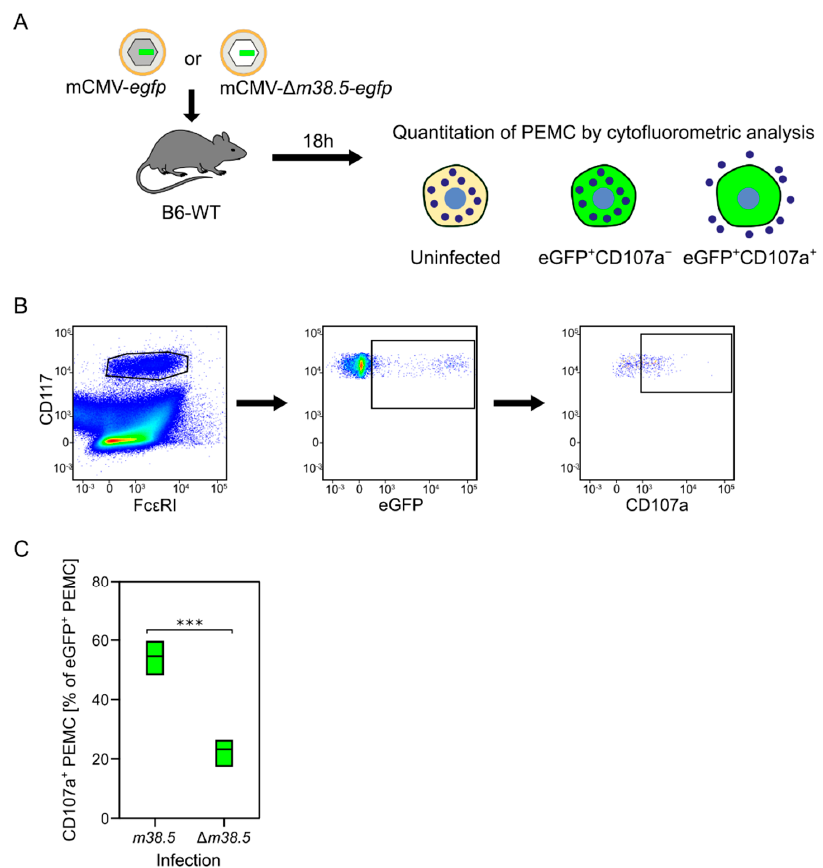
Figure 4. MC degranulation triggered by the anti-apoptotic mCMV protein vMIA-m38.5. ( A ) Sketch of the experimental protocol. C57BL/6 mice were infected intraperitoneally with mCMV recombi- nants containing (grey-shaded capsid) or lacking (empty capsid) gene m38.5 . Both virus genomes include gene egfp coding for the fluorescent reporter protein eGFP (green) that identifies infected MC. Peritoneal exudate MC (PEMC) were isolated from the peritoneal cavity 18 hours (h) after infection. ( B ) Gating strategy for cytofluorometric analysis identifying CD117 + Fc ε R1 + PEMC that either have remained uninfected (eGFP − ) or were infected but have not, or not yet, degranulated (eGFP + CD107a − ), or were infected and have already degranulated (eGFP + CD107a + ). ( C ) Relative quantitation of infected eGFP + CD117 + Fc ε RI + CD107a + PEMC degranulated after infection with either mCMV- egfp expressing vMIA-m38.5 or deletion mutant mCMV- ∆ m36.5- egfp . Green bars represent range of data from individual mice, with median values marked. (***) highly significant with p < 0.001. Results are displayed graphically modified and in a new arrangement, based on original data published in